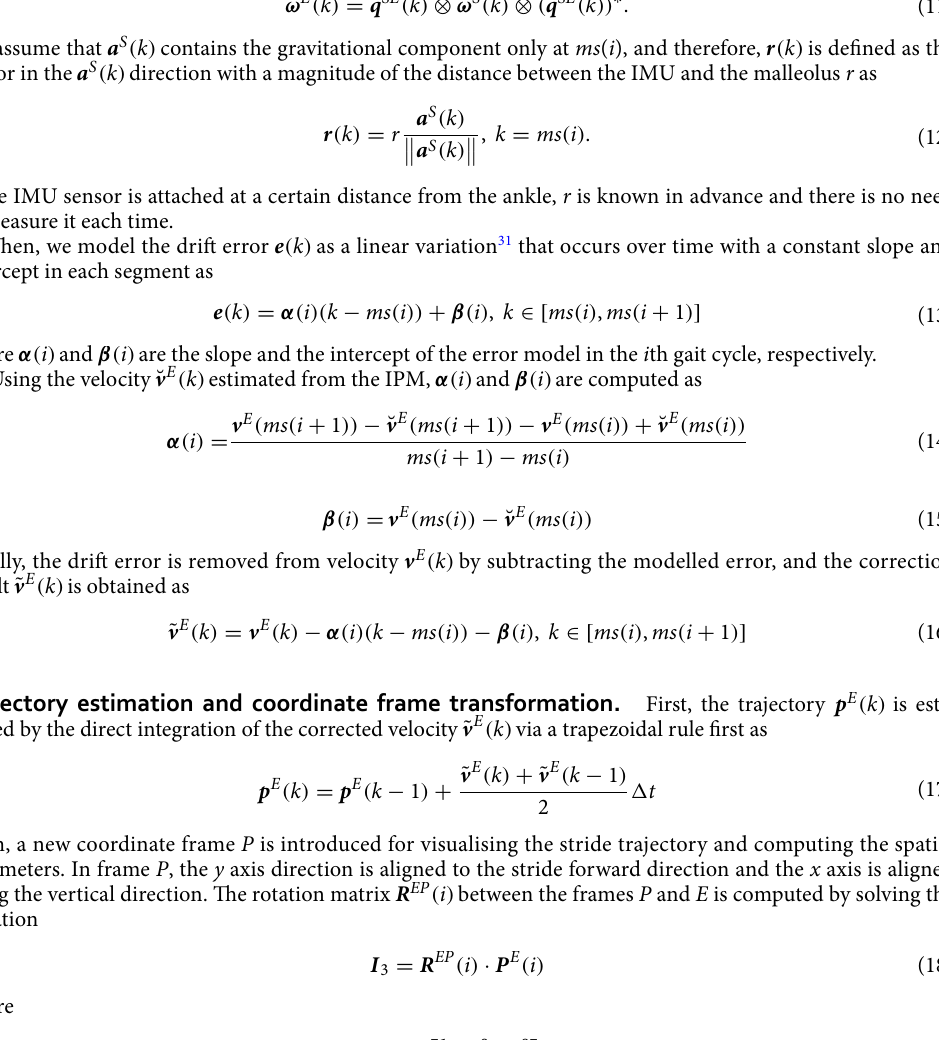
Figure 5. Motion of the IMU at the mid-stance can be modelled as a rotational motion in a three-dimensional space. The position vector r and angular velocity in laboratory coordinate frame ω estimated orientation of IMU. Thus, the update velocity ˘ v E with r and ω